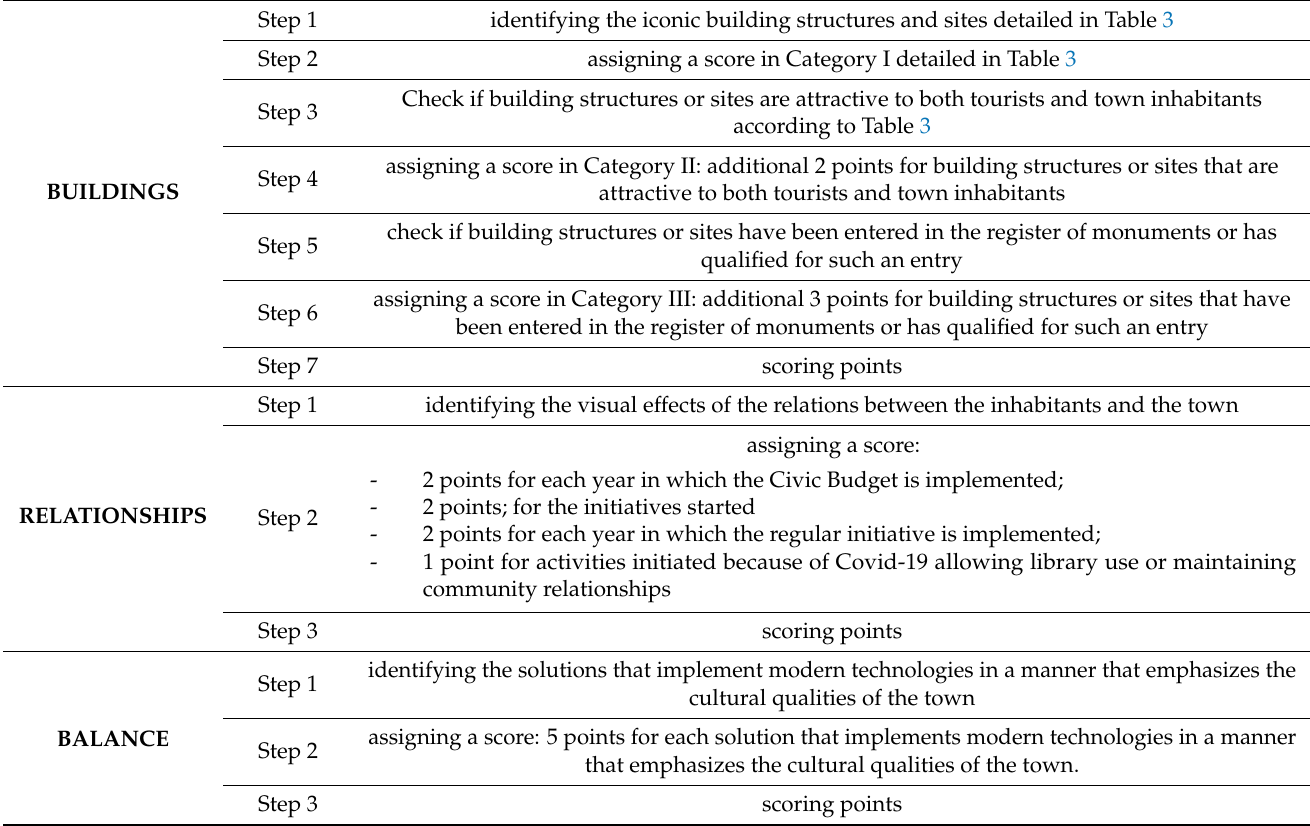
Table 4. Steps of the BRB